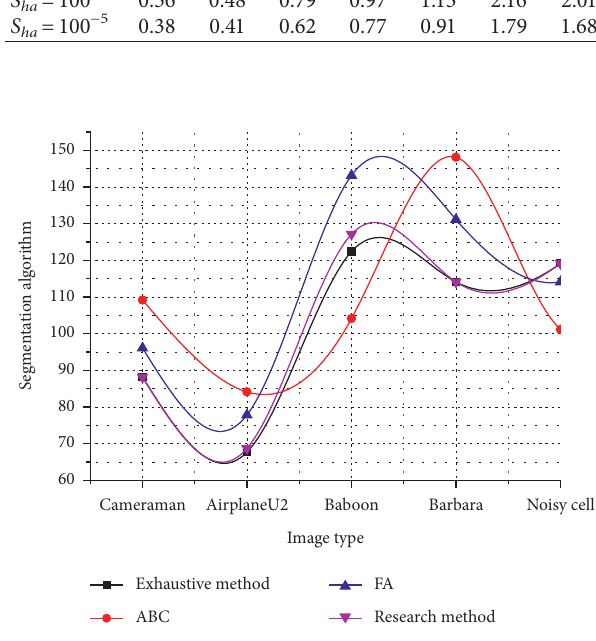
Figure 3: Comparison of segmentation thresholds.